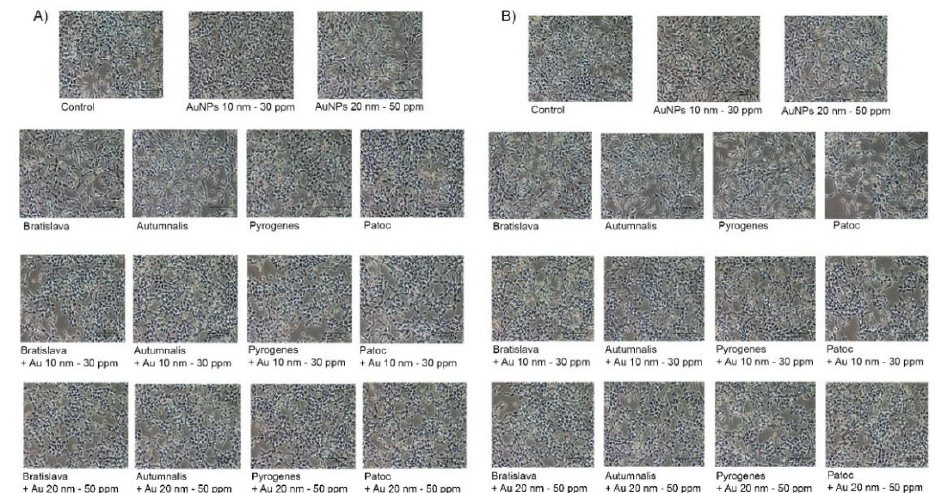
Figure 4. The morphological changes of AuNP-exposed HEK-Blue-hTLR2 cells ( A ) and HEK-Blue-Null1 cells ( B ) with and without Leptospira serovars under phase contrast microscopy.